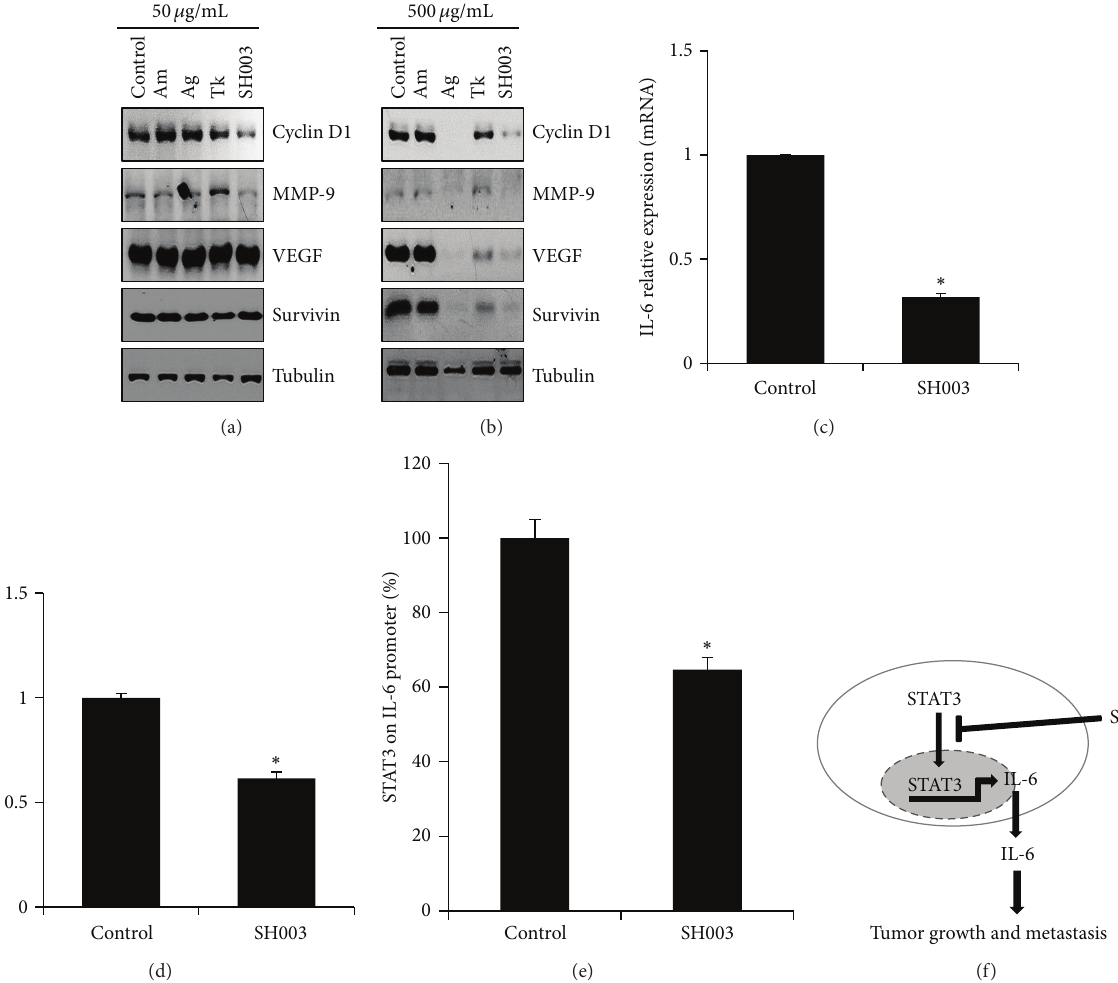
Figure 6: SH003 inhibits STAT3 target gene expression. ((a) and (b)) MDA-MB-231 cells were treated with the indicatives at 50 or 500 𝜇 g/mL for 24 hours and then subjected to western blots with the antibodies indicated. Tubulin was detected as a loading control. (c) MDA-MB-231 cells were treated with the indicatives at 500 𝜇 g/mL for 24 hours and then subjected to real-time PCR for IL-6 mRNA expression levels. Experiments were performed in triplicate. Bars indicate means and standard deviations. ∗ 𝑃 < 0.05 . (d) MDA-MB-231 cells were treated with the indicatives at 500 𝜇 g/mL for 24 hours and then harvested culture media. IL-6 levels were analyzed with ELISA assay. Experiments were performed in triplicate. Bars indicate means and standard deviations. ∗ 𝑃 < 0.05 . (e) Cells were treated with SH003 for 6 hours and then subjected to chromatin immunoprecipitation assays to test STAT3 interaction with IL-6 promoter. (f) A schematic model for anti-TNBC roles of SH003. TNBC has highly metastatic characteristics with constitutively active STAT3. SH003 selectively targets STAT3-dependent IL-6 production, resulting in the inhibition of TNBC growth and